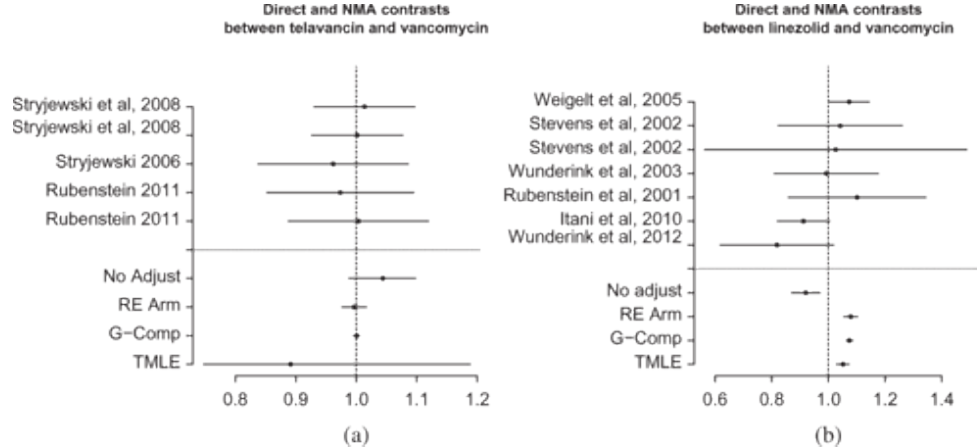
Figure 2: Risk ratio estimates and confidence intervals for clinical success at test of cure for all studies with direct compar- isons and all network meta-analysis methods for the contrasts between a) telavancin and vancomycin and b) linezolid and vancomycin. Risk ratio values below one indicate superiority of